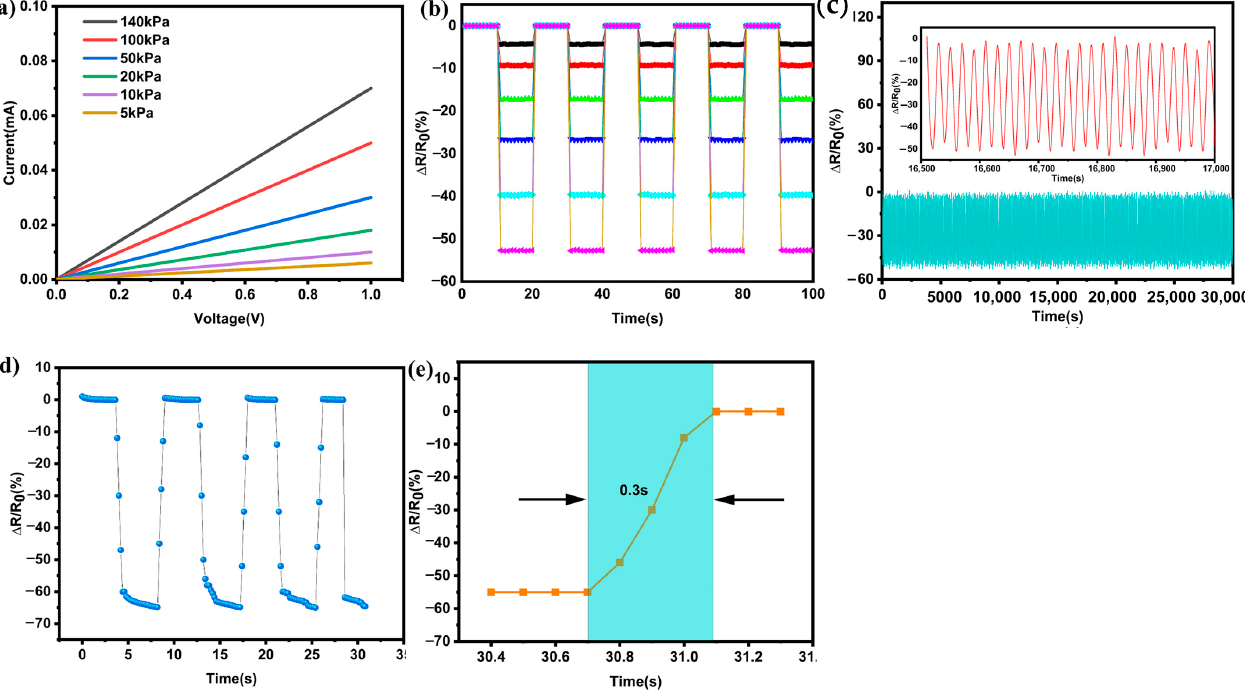
Figure 7. Electrical and mechanical test of the rGO-PDMS. ( a ) I-V curves of the rGO-PDMS with various amounts of applied pressure; ( b ) repeated cyclic tests of loading and unloading pressure at 5, 10, 20, 50, 100, and 140 kPa, respectively; ( c ) stability test of the rGO-PDMS sensor for 30000 cycles of loading and unloading; ( d ) response time of rGO-PDMS sensor upon loading/unloading; ( e ) expanded view of rGO-PDMS sensor response time.